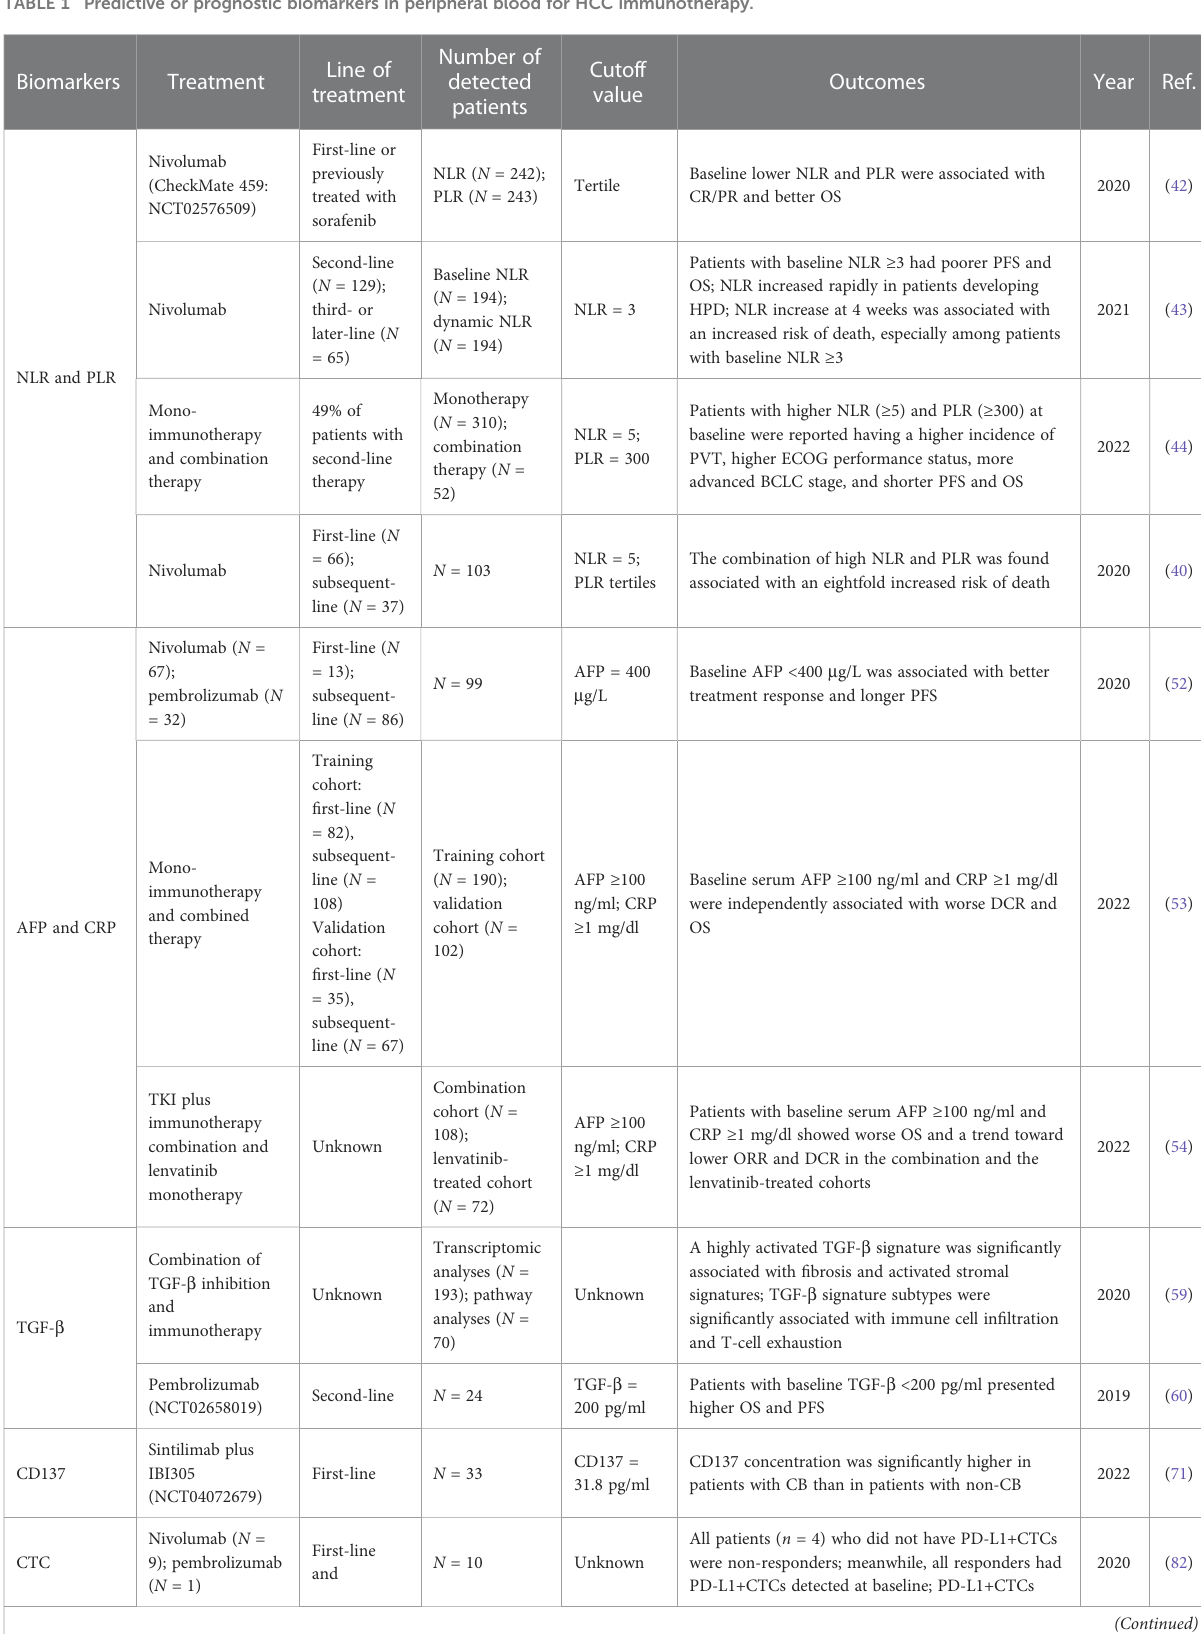
TABLE 1 Predictive or prognostic biomarkers in peripheral blood for HCC immunotherapy.